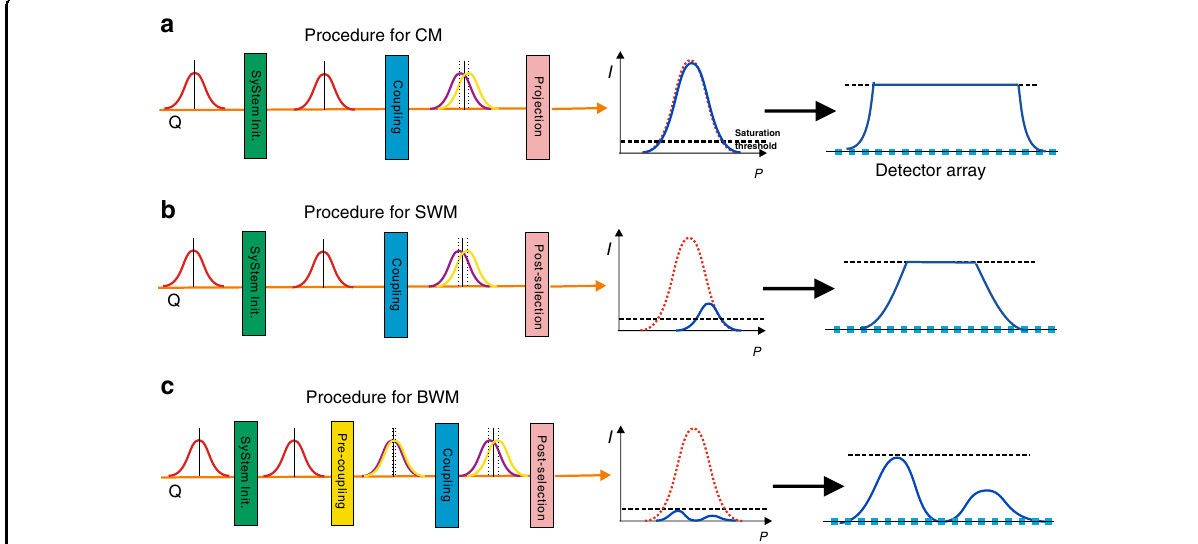
Fig. 1 Diagram of CM, SWM, and BWM schemes. The procedures to implement CM, SWM, and BWM are shown in a – c , respectively. All these three methods start from a system initialization, and all involve a coupling between the system and meter. In CM, a projective measurement is made on the system and the coupling strength can be estimated from the change in photon counting for each pixel. In SWM, a post-selection is applied to amplify the shift of the mean value of observable ^ P . This post-selection makes SWM more robust to DSE compared with CM; however, the detector array eventually saturates for these two methods when too many photons are received. In BWM, an additional pre-coupling is introduced before the coupling; consequently, the post-selection discards more photons than SWM and leads to an extinction point for the distribution of p , which enables the detector array to work below the threshold for a much larger photon number. Furthermore, the position of this extinction point is extremely sensitive to the coupling strength. Therefore, BWM is more robust to DSE and eventually attains better precision than those of CM and